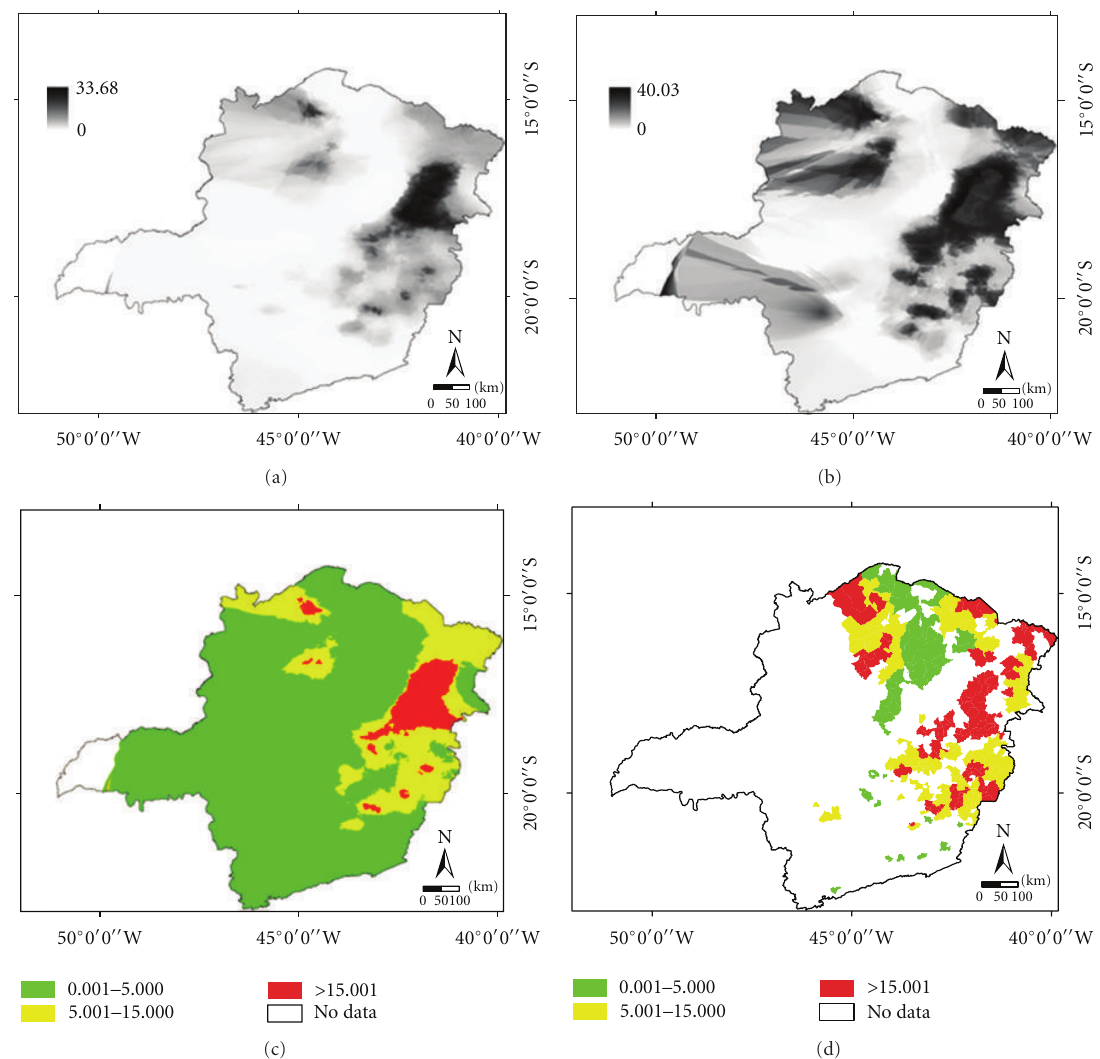
Figure 3: (a) Estimated prevalence by kriging, (b) map of the uncertainties, (c) estimated prevalence by kriging by type of classes, (d) mean estimated prevalence by kriging for 255 municipalities.